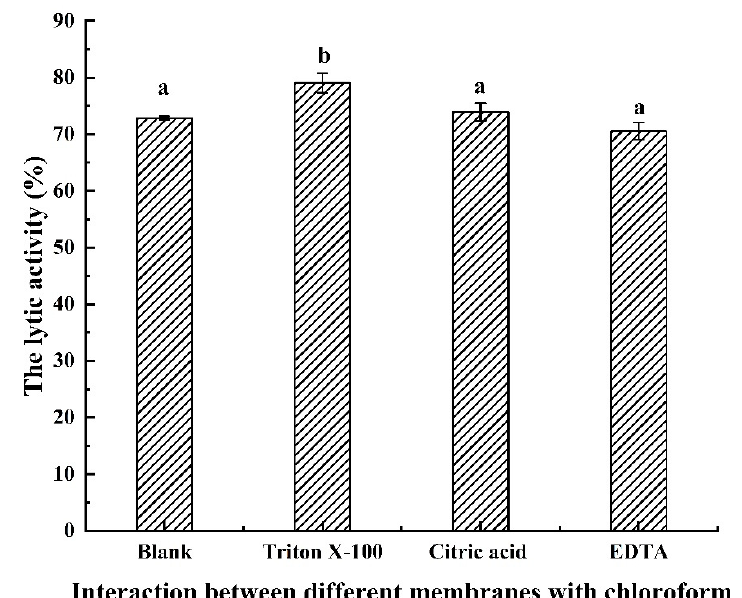
Figure 6. The effect of chloroform combined with three different outer membrance permeabilizers on the lytic ability of LysSE24. Blank: The endolysin LysSE24 (final concentration 100 nM) was added after the cells were treated with chloroform only. The concentrations of the three outer membrance permeabilizers were 0.1% Triton X-100, 2 mM citric acid, and 0.5 mM EDTA. Calculate the lytic activity by using the formula: 100% × (OD 600 nm of control − OD 600 nm of the reaction mixture with endolysins) / the initial OD 600 nm of the control. The different letters (a, b, c, and d) in the figure indicate significant differences ( p < 0.05).